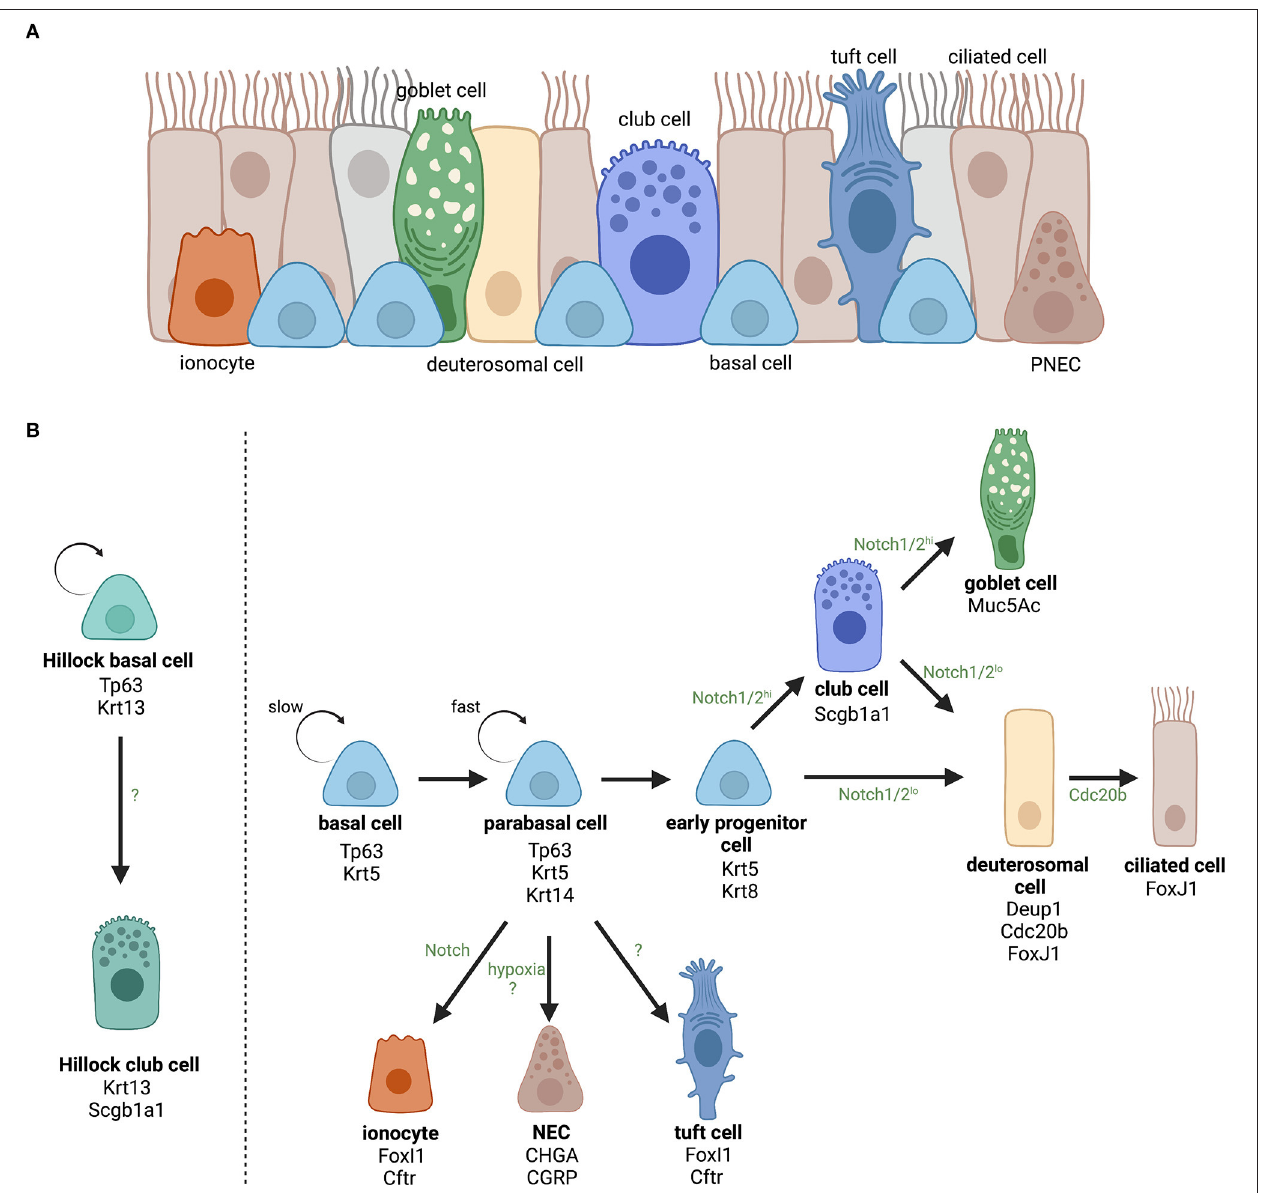
FIGURE 1 | Overview of the identified cell types in the airway epithelium and the current opinion about their lineage hierarchy. (A) The airway epithelium is mainly composed of ciliated, goblet and basal cells and more rare cell types including club cells, ionocytes, neuroendocrine cells (NECs), tuft cells, and deuterosomal cells. (B) The role of basal cells as progenitor cells of the airway epithelium and the lineage hierarchy of differentiated epithelial cells. For each cell (sub)type, the most important cellular markers are indicated. Upon activation, slowly cycling airway basal cells increase their proliferation rate and become fast cycling parabasal cells. Parabasal cells will continue differentiation and lose expression of basal cell marker Tp63 and gain expression of luminal marker Krt8. Activation of Notch signaling will determine epithelial cell fate toward secretory (club and goblet) or ciliated cells for which the level of Notch2 signaling is decisive (2). Ciliated cell differentiation involves the appearance of a transient state, referred to as deuterosomal cells, characterized by a massive biogenesis of centrioles (i.e., the deuterostome), which is a crucial step in multiciliogenesis (3). On the other hand, airway basal cells can also directly differentiate into ionocytes (FoxI1 + and Ctrf + ), NECs (CHGA + and CGRP + ), or tuft cells (Pouf2f2 + and Trpm5 + ). However, it is still unclear which signaling pathways are involved in those lineages. In addition, in specific squamous epithelial structures termed “Hillocks” Tp63 + /Krt13 + basal cells give rise to Scgb1a1 + /Krt13 + club cells. Created with BioRender.com.